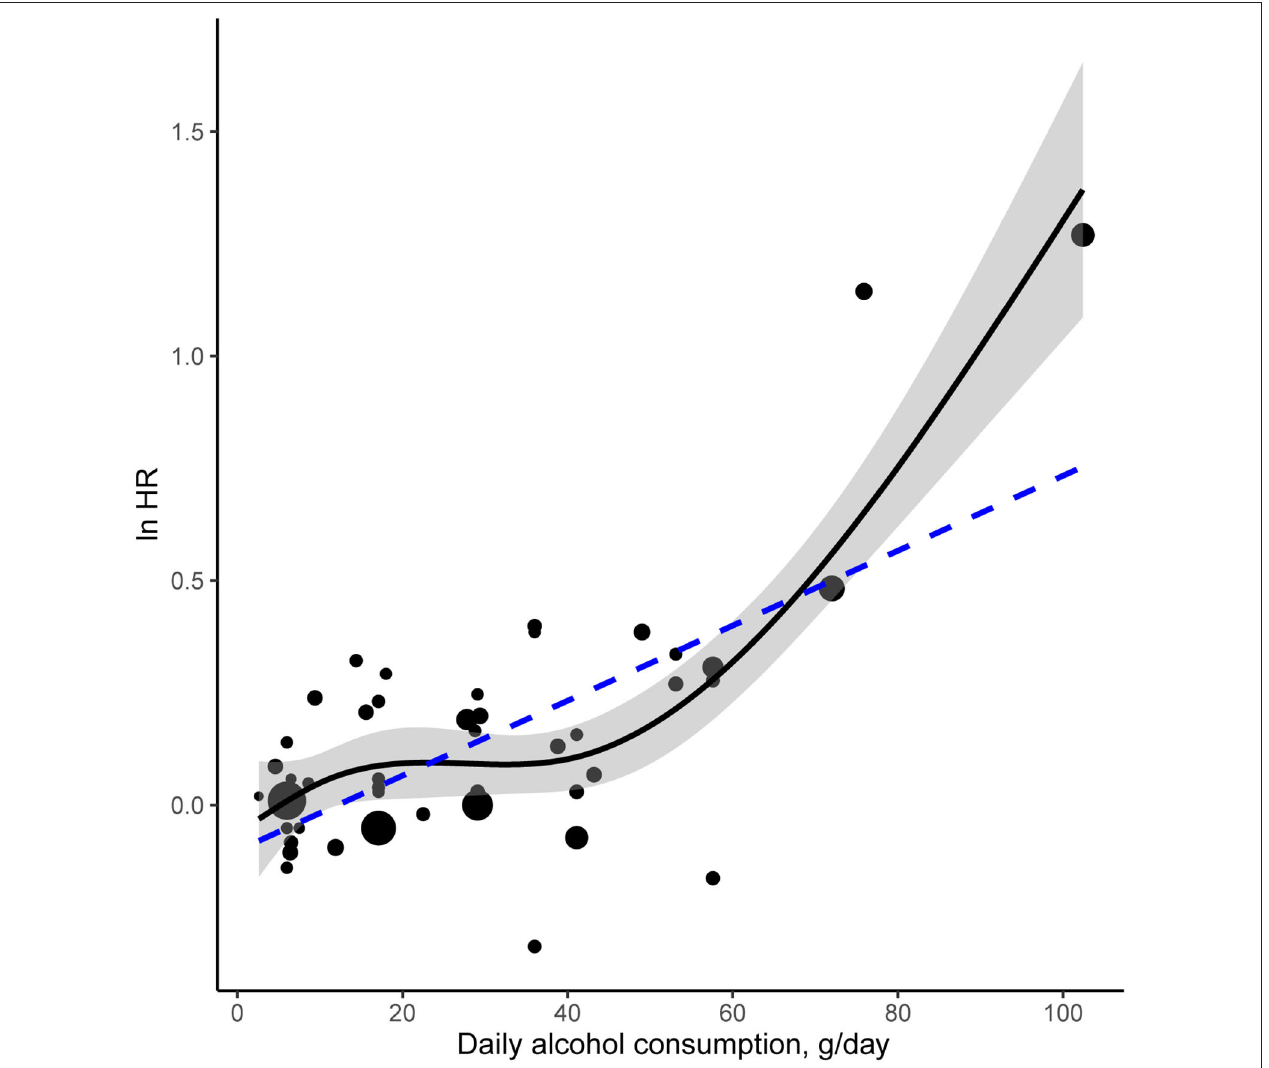
FIGURE 5 | A dose-response meta-analysis of alcohol consumption and risk of AF. The solid curve and the shadow area indicate the ln(HR) with a corresponding 95% confidence interval based on a restricted cubic spline regression model with knots 2.6, 10.65, 41.1, 102.4 g/day of alcohol consumption. This model significantly improves the fit compared with the linear regression model illustrated by the dotted line. The area of each data point is proportional to its statistical